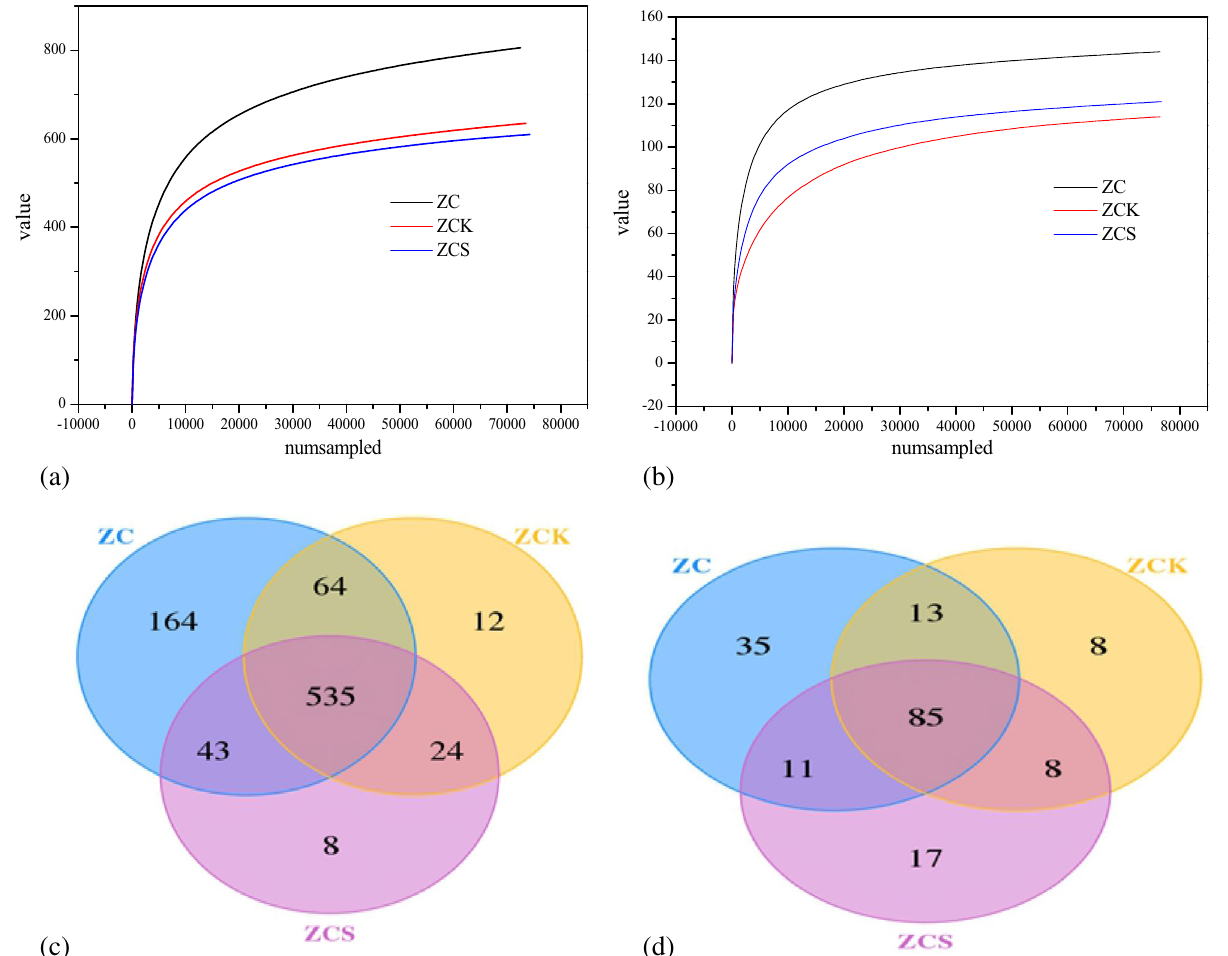
Figure 4. ( a ) Bacterial dilution curve; ( b ) Archaea dilution curve; ( c ) Venn diagram of bacteria; ( d) Venn diagram of archaea.